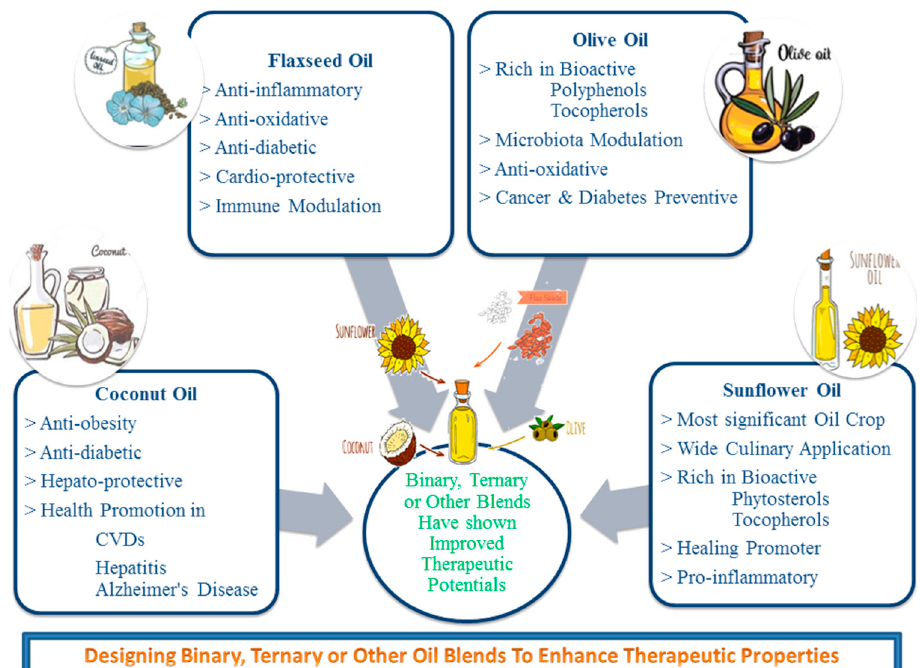
Figure 3. Effect of binary or ternary (CO, FO, OO, SFO) blending on therapeutical potential. Table 3. Therapeutic potential of blends of selected oils (coconut oil, flaxseed oil, olive oil, sunflower oil). Oil